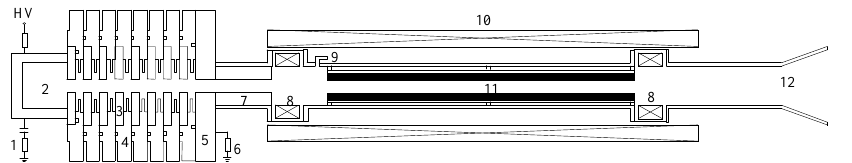
FIG. 1. Cherenkov maser experimental